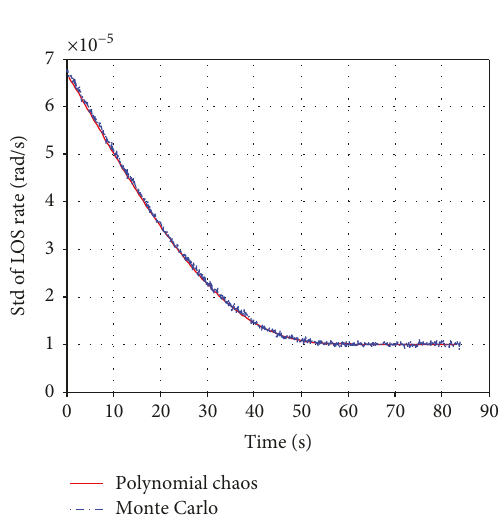
Figure 17: Standard deviation of the LOS rate.